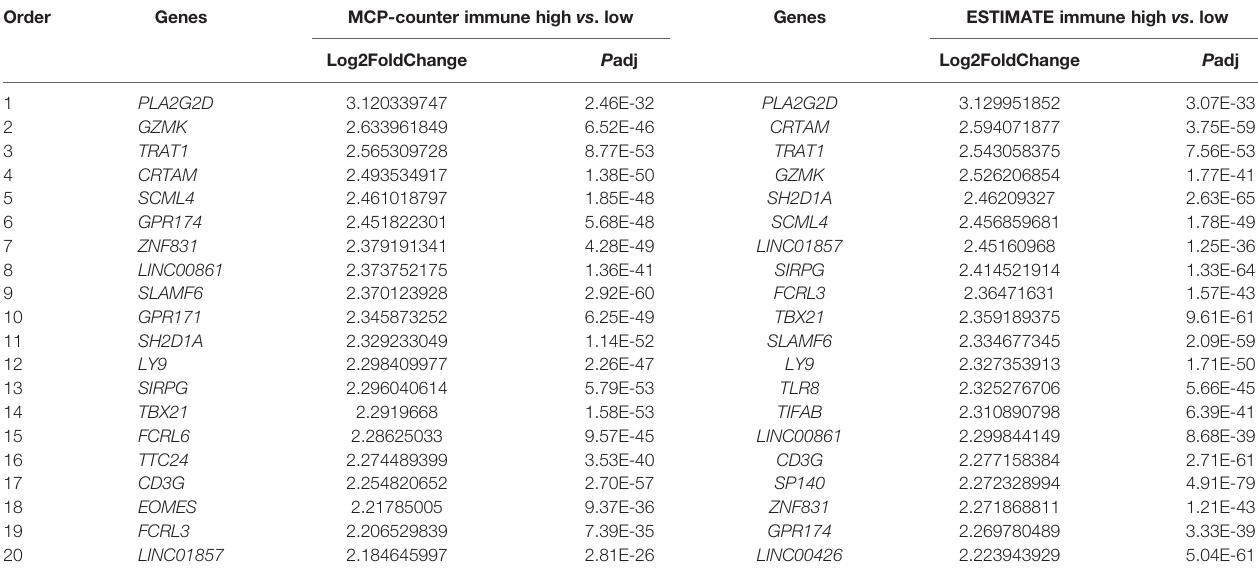
TABLE 1 | Top 20 WGCNA fi ltered genes determined by DEG analysis of high- and low-immune in fi ltration groups classi fi ed by the MCP-counter and ESTIMATE algorithms. Order Genes MCP-counter immune high vs . low